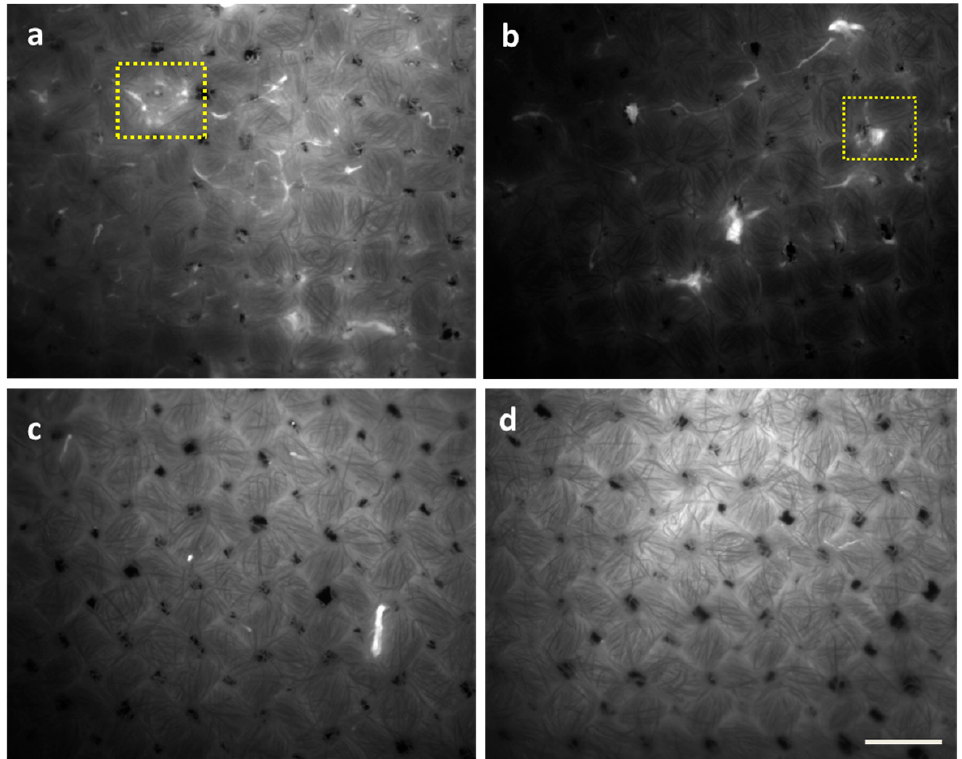
Figure 4. Epifluorescence microscopy images of P. fluorescens grown for 48 h to form biofilms on cellulose substrates after 1 h of washing with detergent-based Formulation 1 ( b ), enzyme-based Formulation 2 ( c ), and the combination of both in F1/2 ( d ). Untreated biofilms are shown in ( a ). Bright spots (indicated by yellow boxes as examples) indicate biomass due to bacteria aggregates and biofilm attachment. Scale bar: 200 μ m.